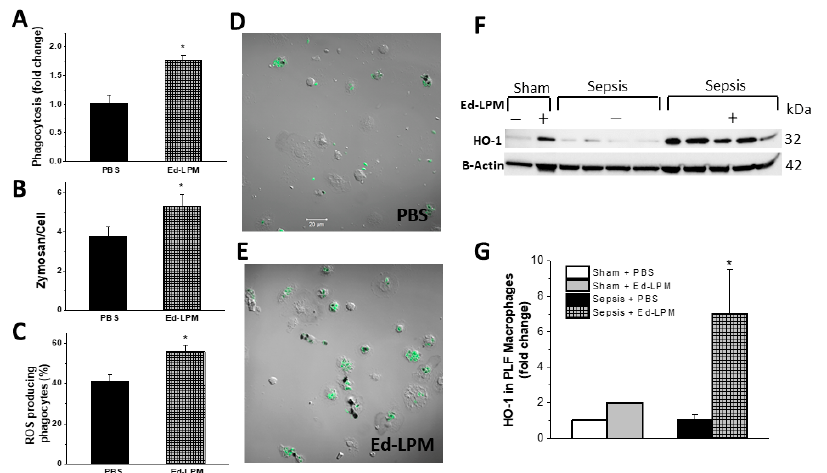
Figure 4. Ed-LPM treatment of septic rats enhances peritoneal macrophage function. Macrophages isolated from the peritoneum of Ed-LPM treated animals 48 h after sepsis induction demonstrated and more effective serum opsonized zymosan (SOZ) phagocytosis (Panel A , B ) and higher ROS production (dark formazan spots) (Panel C ). Representative images of peritoneal macrophage SOZ phagocytosis and ROS production are presented in Panels D , E . Quantification of 3 experiments is shown with samples done in duplicate; * p < 0.05 vs. PBS group. n = 4–5 rats/group; p < 0.0001 for A & C and p = 0.001 for B. Peritoneal macrophages isolated from septic animals treated with Ed-LPMs express more HO-1 compared to macrophages from vehicle-treated septic rats (Panel F , G ). * p < 0.05 vs. Sepsis + PBS group ( t -test, p < 0.0001); n = 8 for PBS-treated and n = 10 for Ed-Mf treated septic group. Sham groups have n = 2/group (for comparison purposes only).